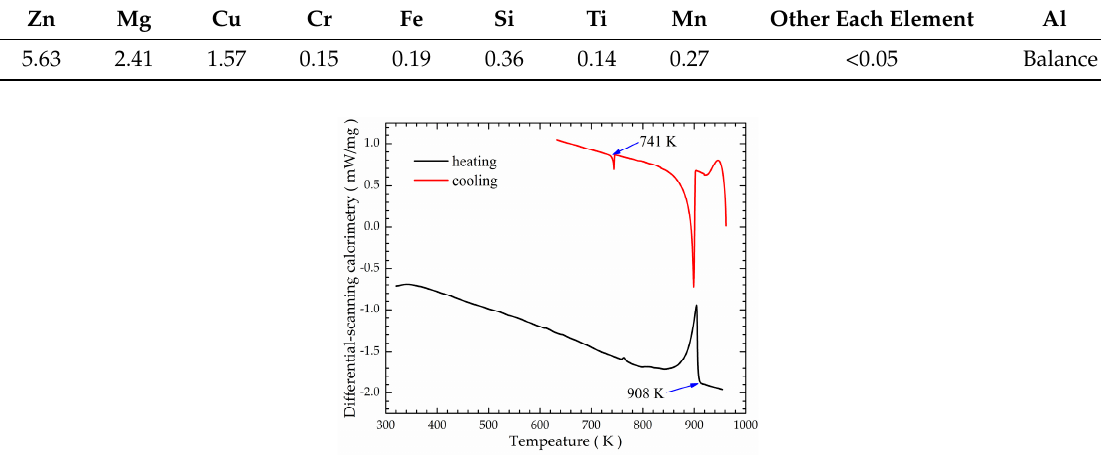
Figure 4. Differential-scanning-calorimetry curves of 7075 alloy.